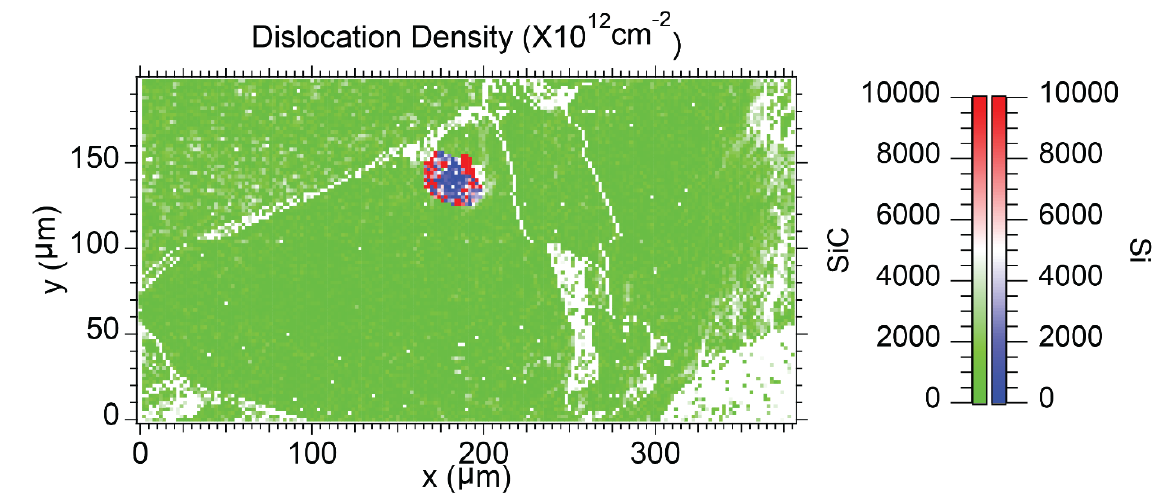
Figure 11. Geometrically necessary dislocation density of the mixed 4H-/6H-SiC region and Si inclusion. Notably the dislocation density of the Si inclusion is high at the edges and low in the middle and the SiC grain shows a very low dislocation density.